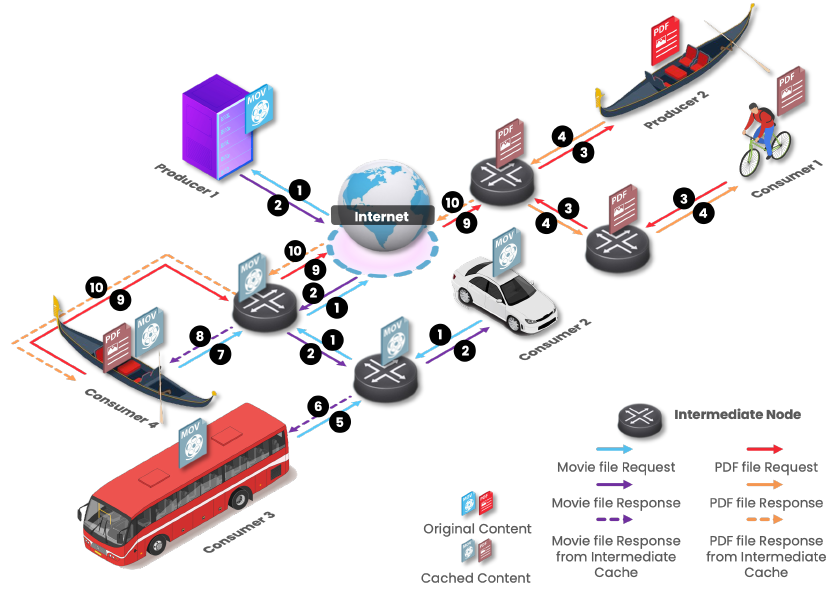
Figure 1. ICN operation mode. Consumers request specific content which is initially stored in the Producers. Then, as this content passes through the intermediary nodes, it is retained in the cache for faster response to future